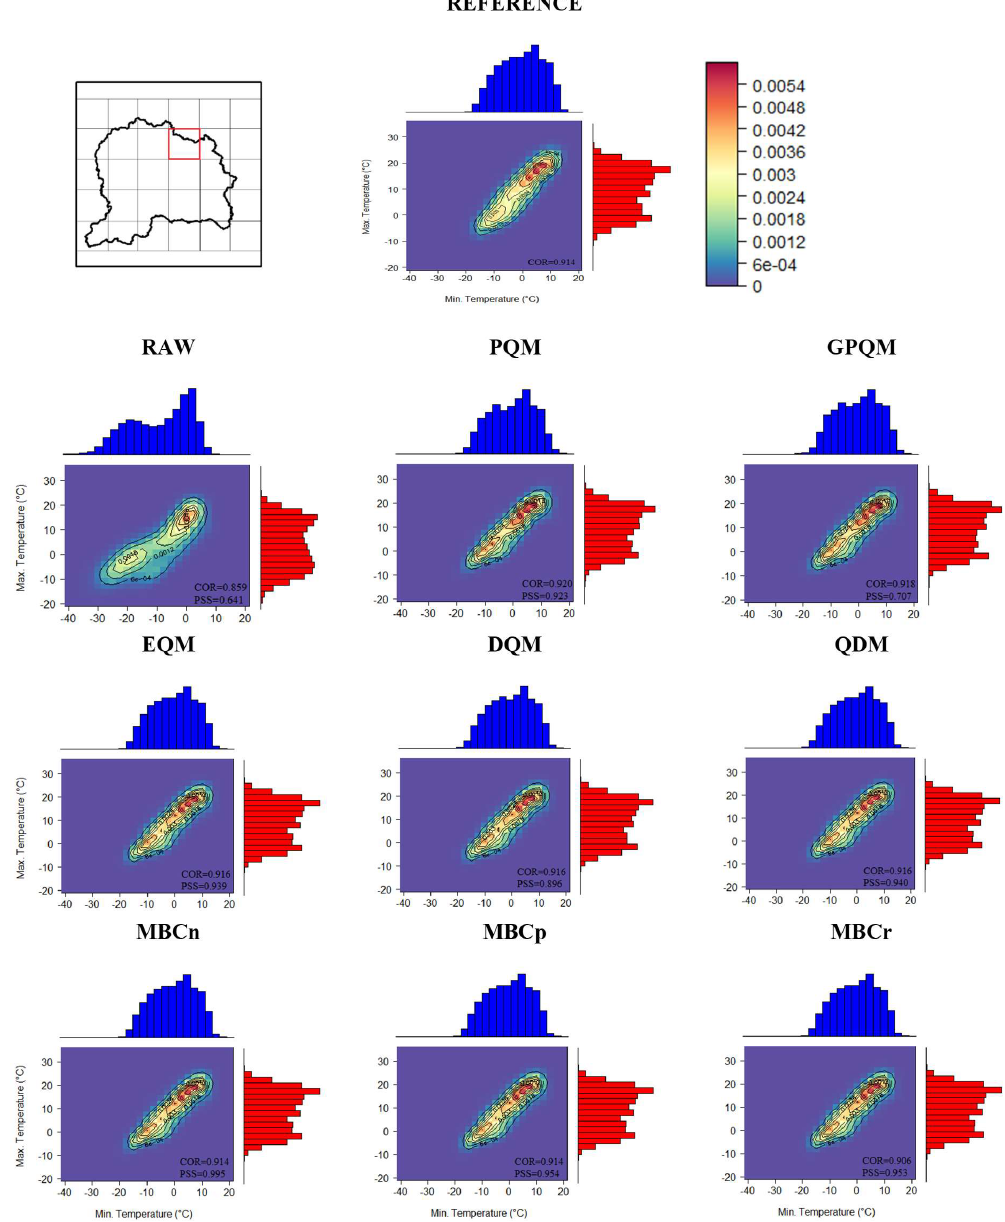
Figure 2. Two-dimensional kernel density plots for the highlighted grid box (red box). Blue histograms (and x axis) refer to minimum temperature, and red histograms (and y axis) refer to maximum temperature. Shadings represent the two-dimensional density distribution for the reference, raw, and eight BC methods. Contour lines represent the probabilities in the reference dataset, which are overlaid on the model probabilities for the sake of comparison. COR depicts the Pearson correlation coefficient between daily minimum and maximum temperatures, and PSS represents the two-dimensional Perkins skill score of distributional